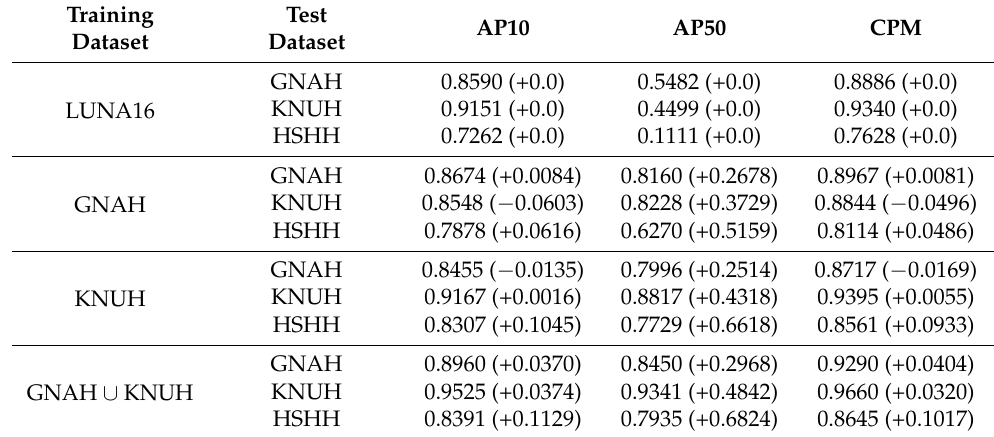
Table 3. Performance Comparison of Collected Private Data and Open Data.